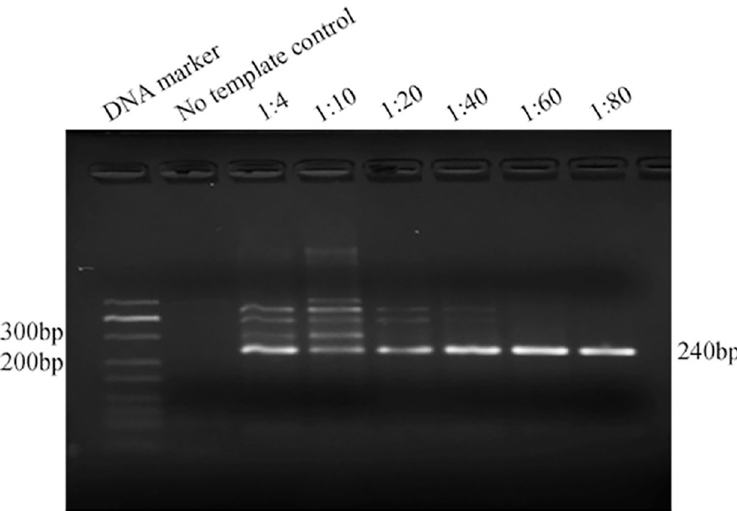
Fig 2. Optimization of the external/inner primer concentration. Lanes 1: DNA marker, lanes 2: no template control, lanes 3–8: ratios of external vs. inner primer (1: 4, 1: 10, 1: 20, 1: 40, 1:60, and 1: 80).